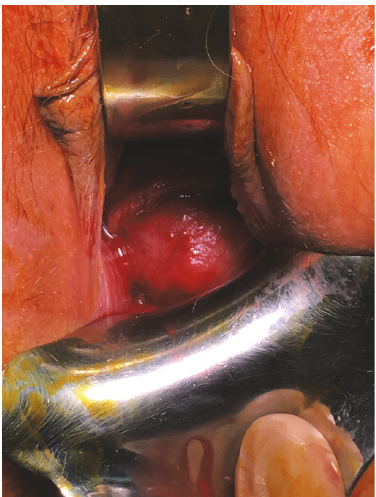
Figure 1: Obstructive cervical fibroid prolapsing through into vagina.